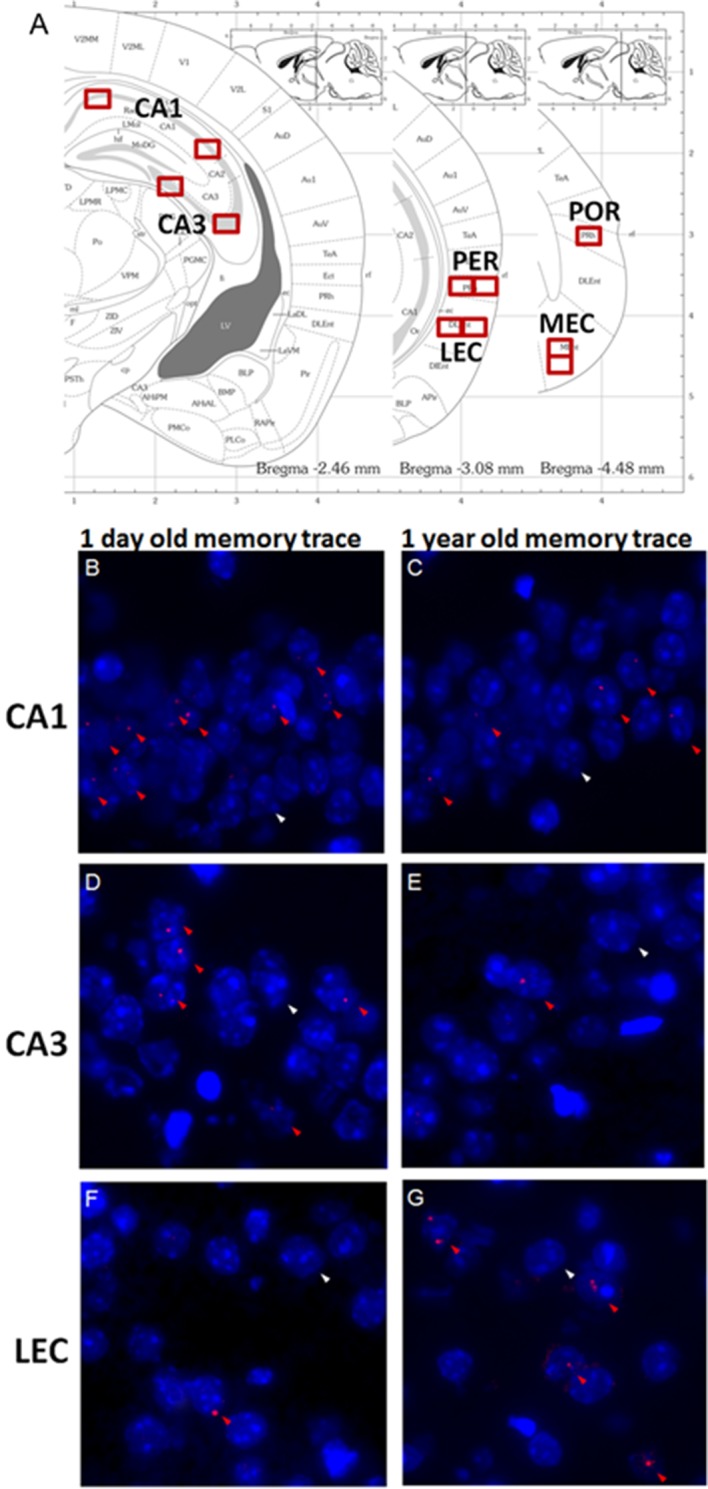
Imaging brain activity in the medial temporal lobe (MTL).(A) Location of counting frames for CA1, CA3, the perirhinal (PER), the lateral entorhinal (LEC), the postrhinal (POR) and the medial entorhinal cortices (MEC). Task-induced Arc nuclear RNAs’ expression was detected on three nonconsecutive brain slices for each target area covering approx. 800 microns. (B-G) Cells activated during the retrieval of one day–old and one year-old memory traces in CA1, CA3 and the LEC: Arc positive cells (red arrowheads) and an exemplar of non-activated cells Arc negative cells (white arrowheads). Cell nuclei are labeled in blue with DAPI. (B,C) CA1 is engaged independently of the age of the memory trace while (D,E) activity levels in CA3 are negligible for very remote memories. (F-G) The parahippocampal areas, for example the LEC, are maximally engaged during the retrieval of very remote memories.